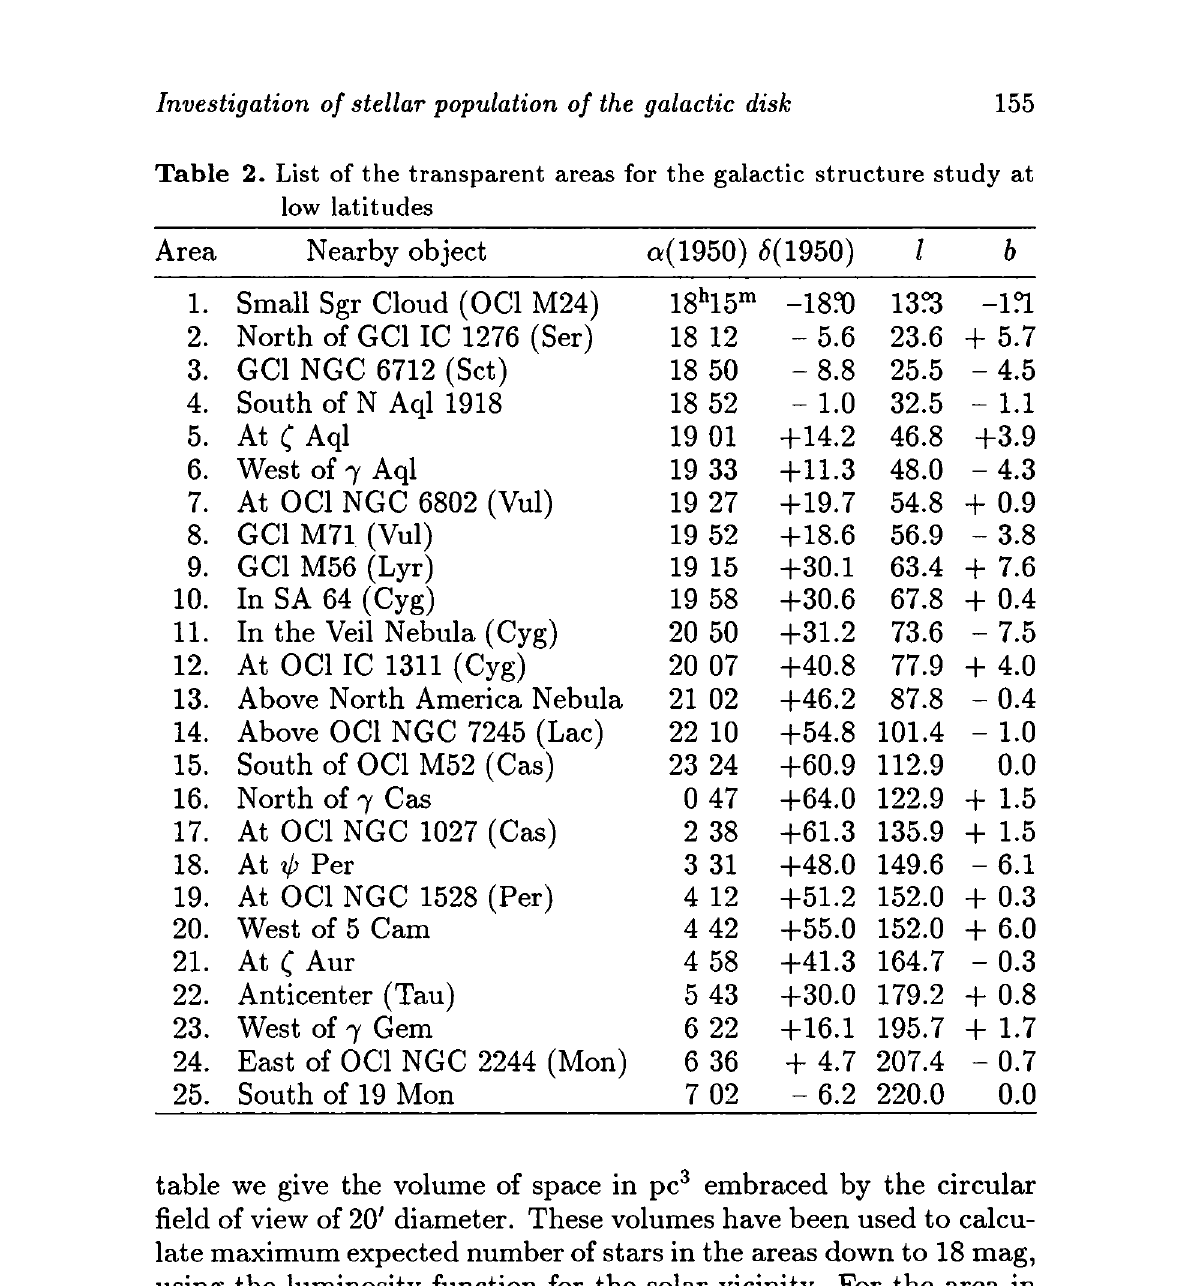
Table 2. List of the transparent areas for the galactic structure study at low